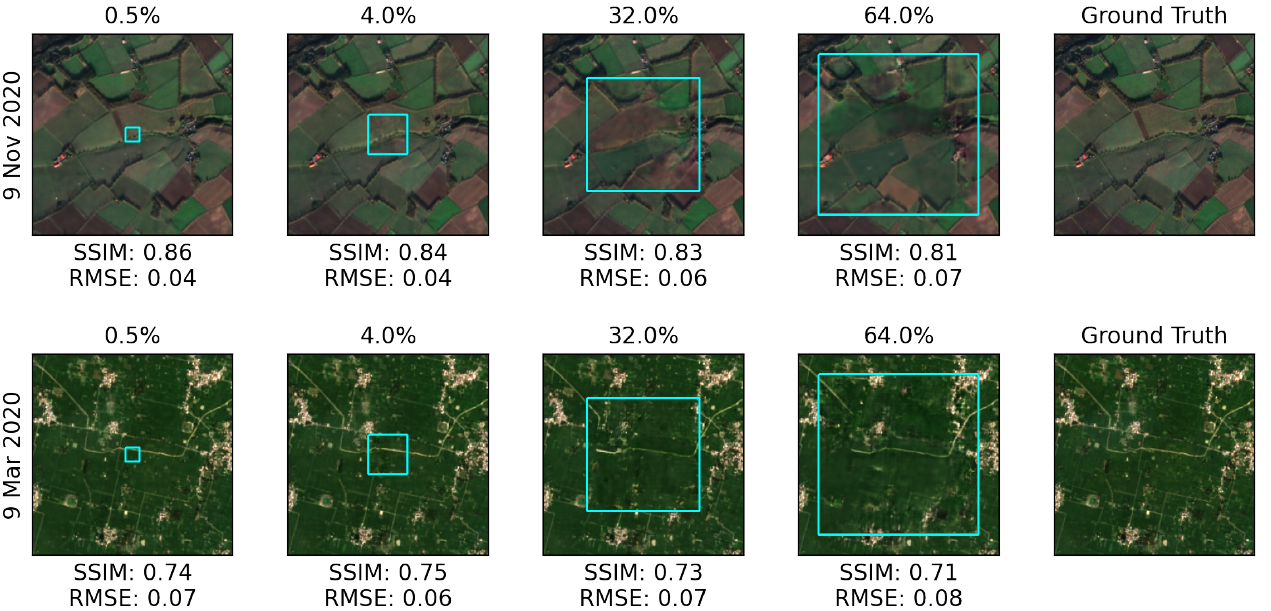
Figure 5. SSIM and RMSE plots for the cloud coverage sweeps for MS-MT mode for the ( a ) Scotland region and ( b ) India region.